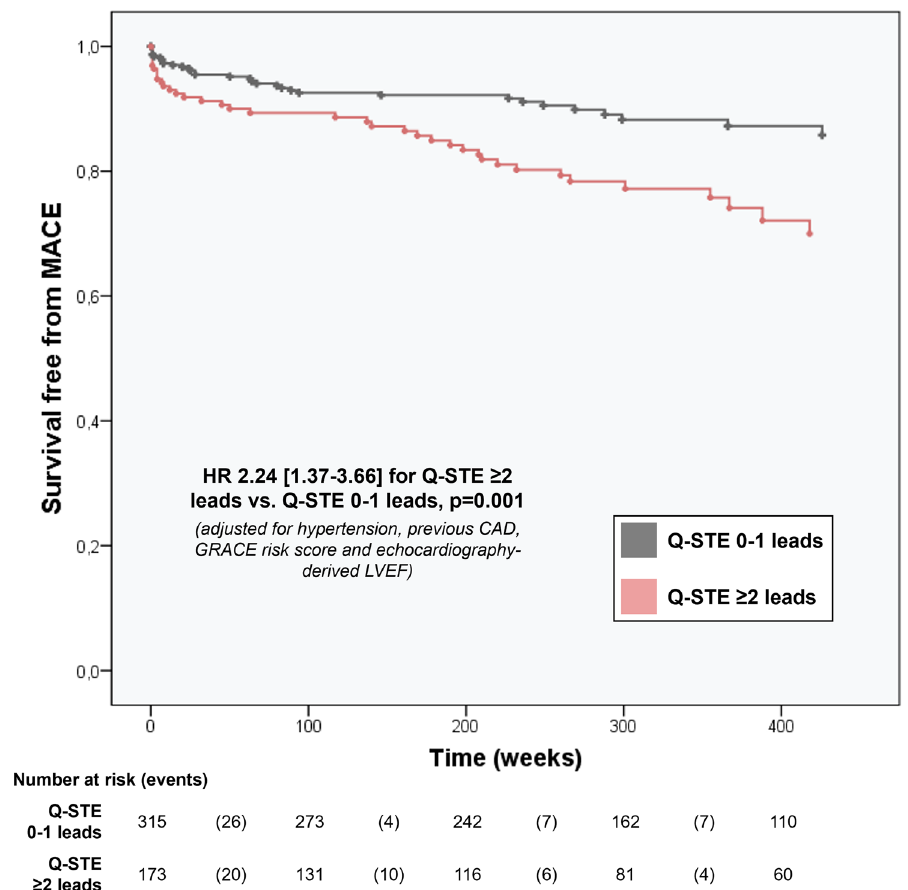
Figure 1. MACE-free survival by Q-STE category. Survival curves adjusted for predictors of MACE other than Q-STE (hypertension, previous CAD, GRACE risk score and echocardiography-derived LVEF). Abbreviations: CAD = coronary artery disease. GRACE = Global Registry of Acute Coronary Events. HR = hazard ratio. LVEF = Left ventricular ejection fraction. MACE = major adverse cardiovascular events. Q-STE = Q wave and residual STE > 1